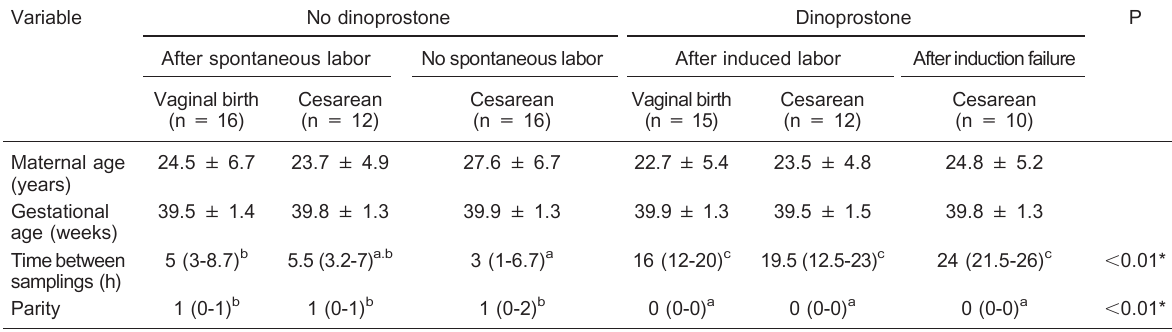
Table 1. Maternal age, gestational age, time between samplings, and parity of patients with and without dinoprostone treatment.